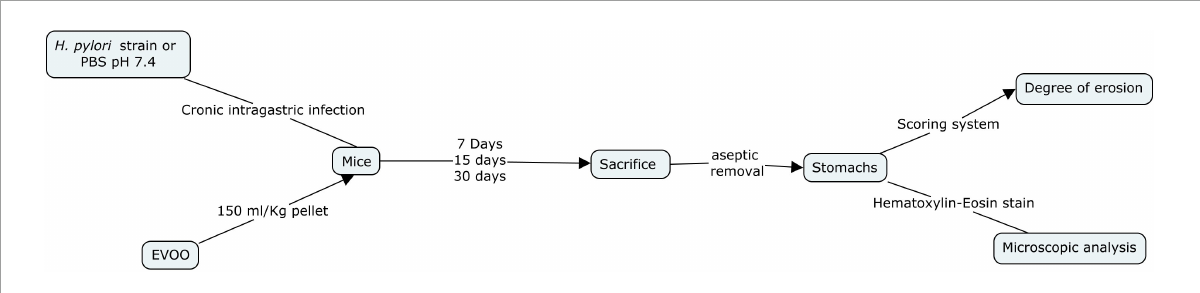
FIGURE3 Flow diagram of the in vivo study of extra virgin olive oil (EVOO) against the infection of Helicobacter pylori strains NCTC 11638 in the gastric mucosa of mice (Behzadi and Gajdács, 2021).